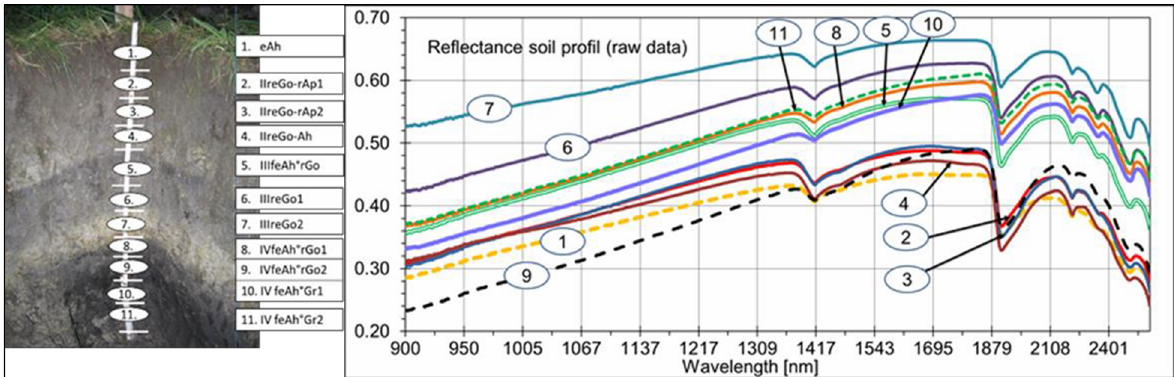
Figure 5. Spectral behavior of the different horizons and vertical discontinuities of the investigated soil profile.